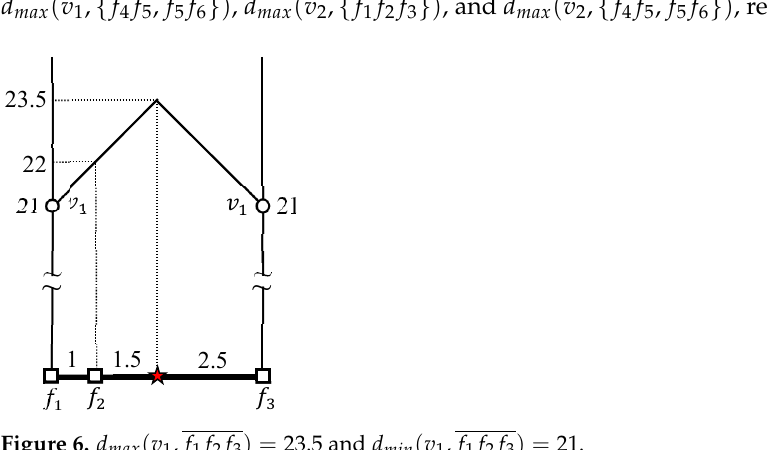
The largest and smallest distances between a facility cluster F C and a border point q b of the query segment are computed using the example in Figure 5, where q b ∈{ v 1 , v 2 } and